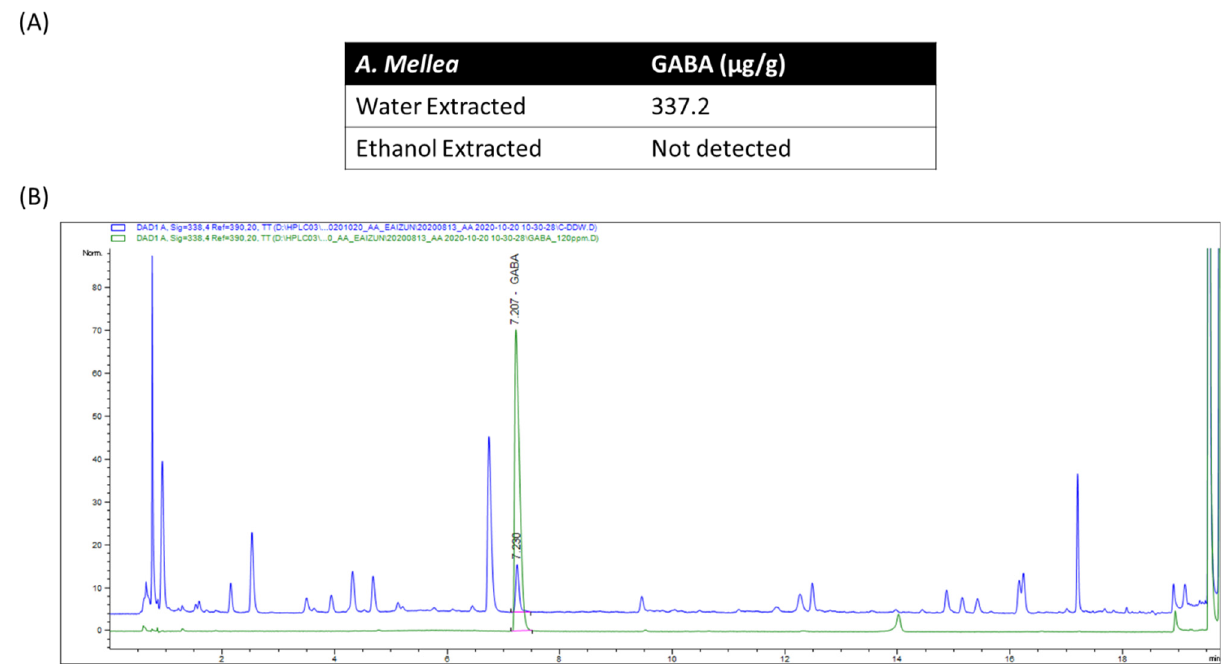
Figure 4. GABA quantification as evaluated by HPLC-DAD. ( A ) Concentration of GABA in water and ethanol extracted A. mellea . ( B ) Representative HPLC chromatograms of GABA standard sample ( bottom ) and the water extract of A. mellea mycelium ( top ) from 20-ton bioreactor (UV detection at 338 nm). Retention time of GABA was 7.2 min.